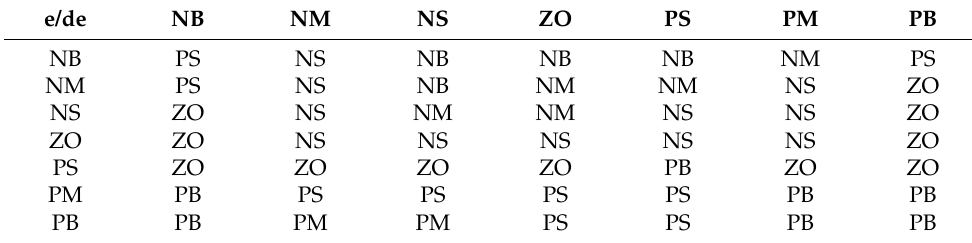
Table 5. Fuzzy rule of the ∆ k d